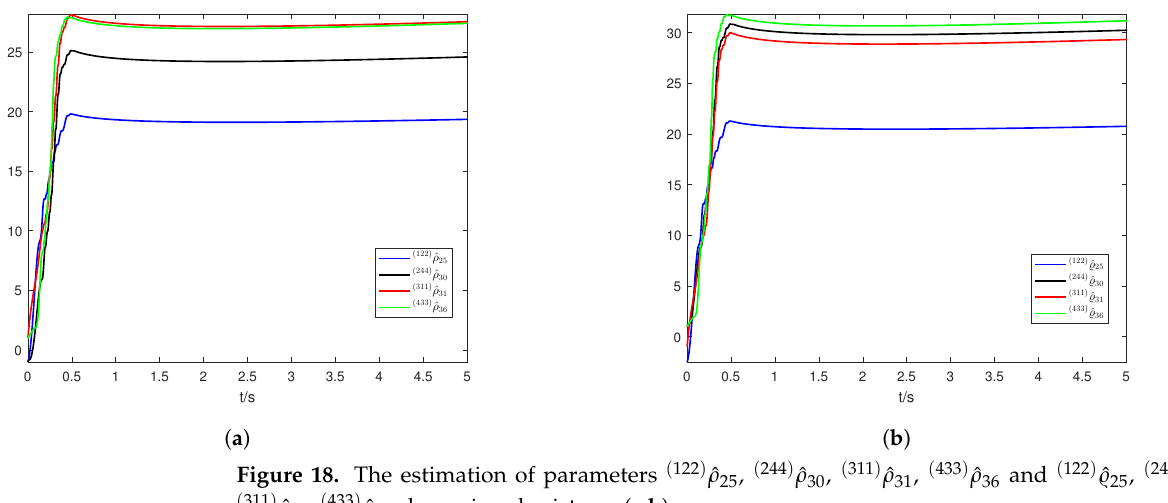
Figure 18. The estimation of parameters ( 122 ) ˆ ρ 25 , ( 244 ) ˆ ρ 30 , ( 311 ) ˆ ρ 31 , ( 433 ) ˆ ρ 36 and ( 122 ) ˆ (cid:36) 25 , ( 244 ) ˆ (cid:36) 30 , ( 311 ) ˆ (cid:36) ( 433 ) ˆ (cid:36) 36 shown in sub-pictures ( a , b 31 ,